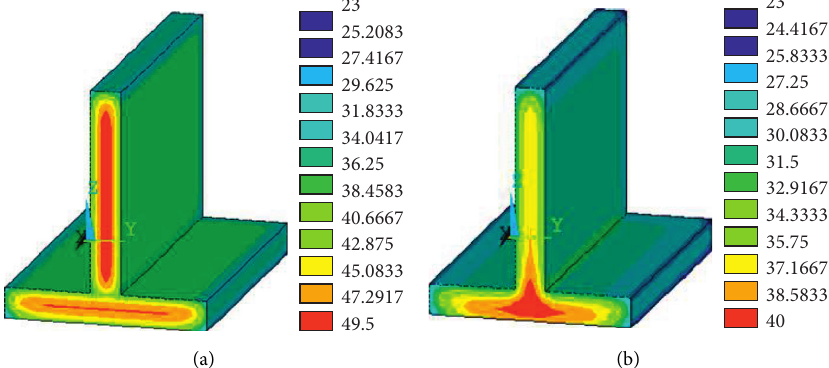
Figure 7: Temperature envelope diagram of BC and IC in vertical flow direction of sluice model ( ° C).